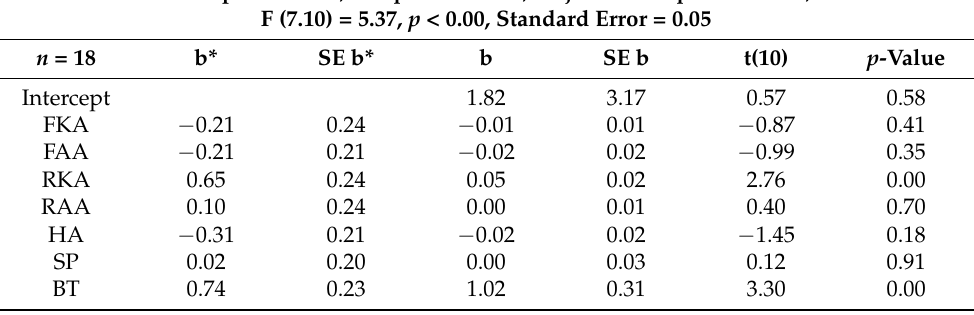
Table 4. Regression analysis for the block phase.